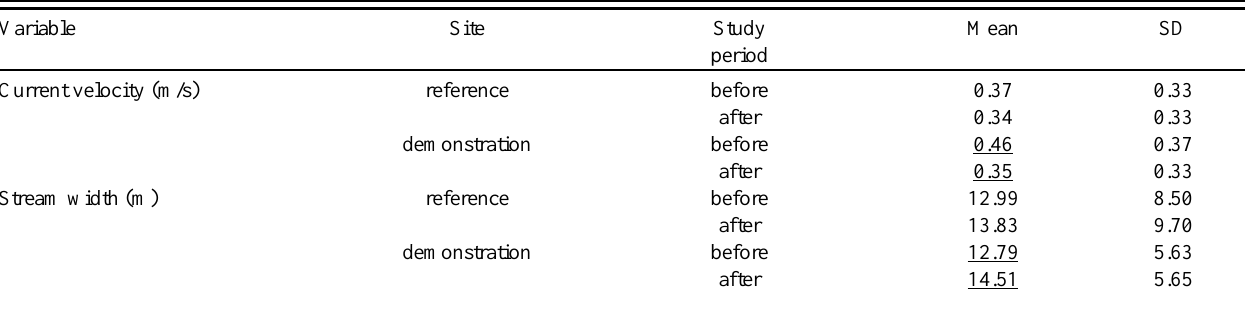
Table 1 . Mean and standard deviation (SE) for measured parameters in the streams per site and study period, in low and medium water-flow conditions